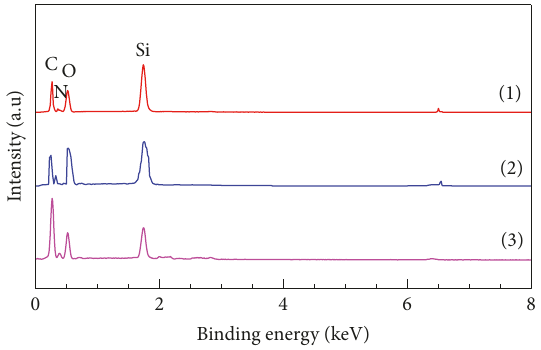
Figure 3: EDS spectra of (1) SPO1, (2) SPO2, (3) SPO3.